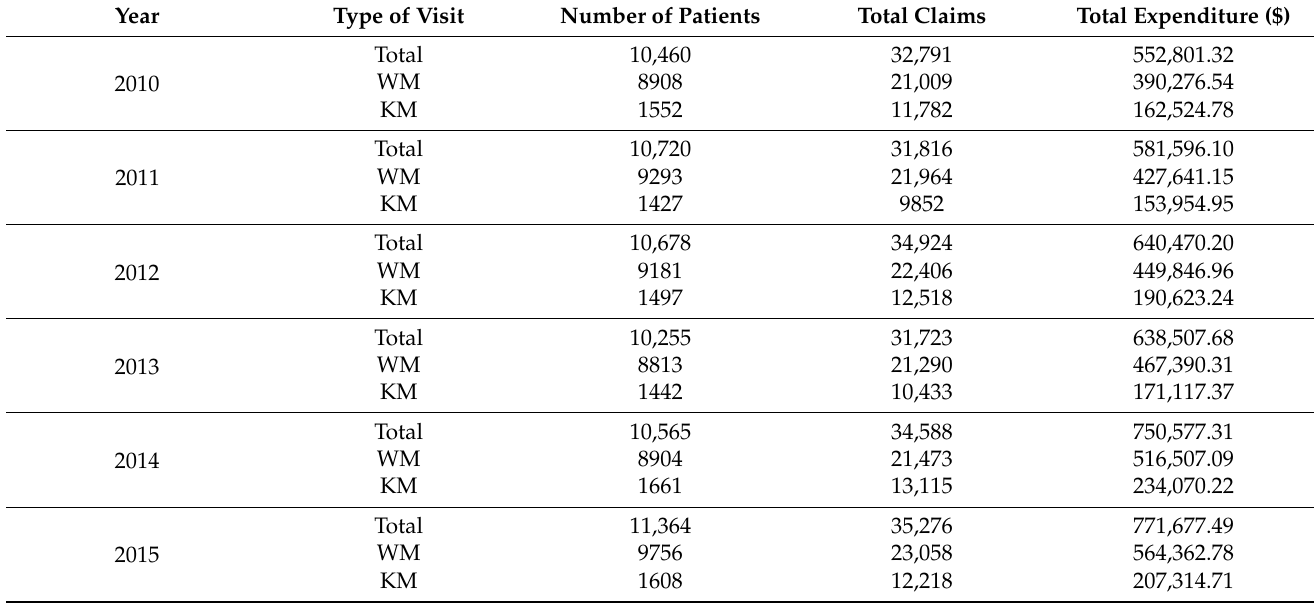
Table 1. General medical services use for patients with Tinnitus in Korea. Type of Visit Number of Patients Total